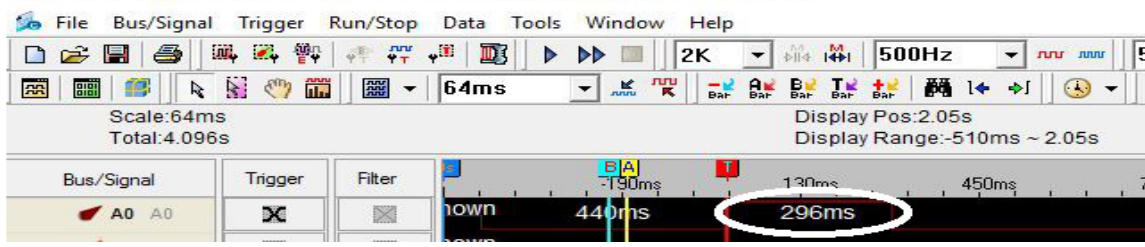
Table 9. Power dissipation analysis of the proposed TRNG.